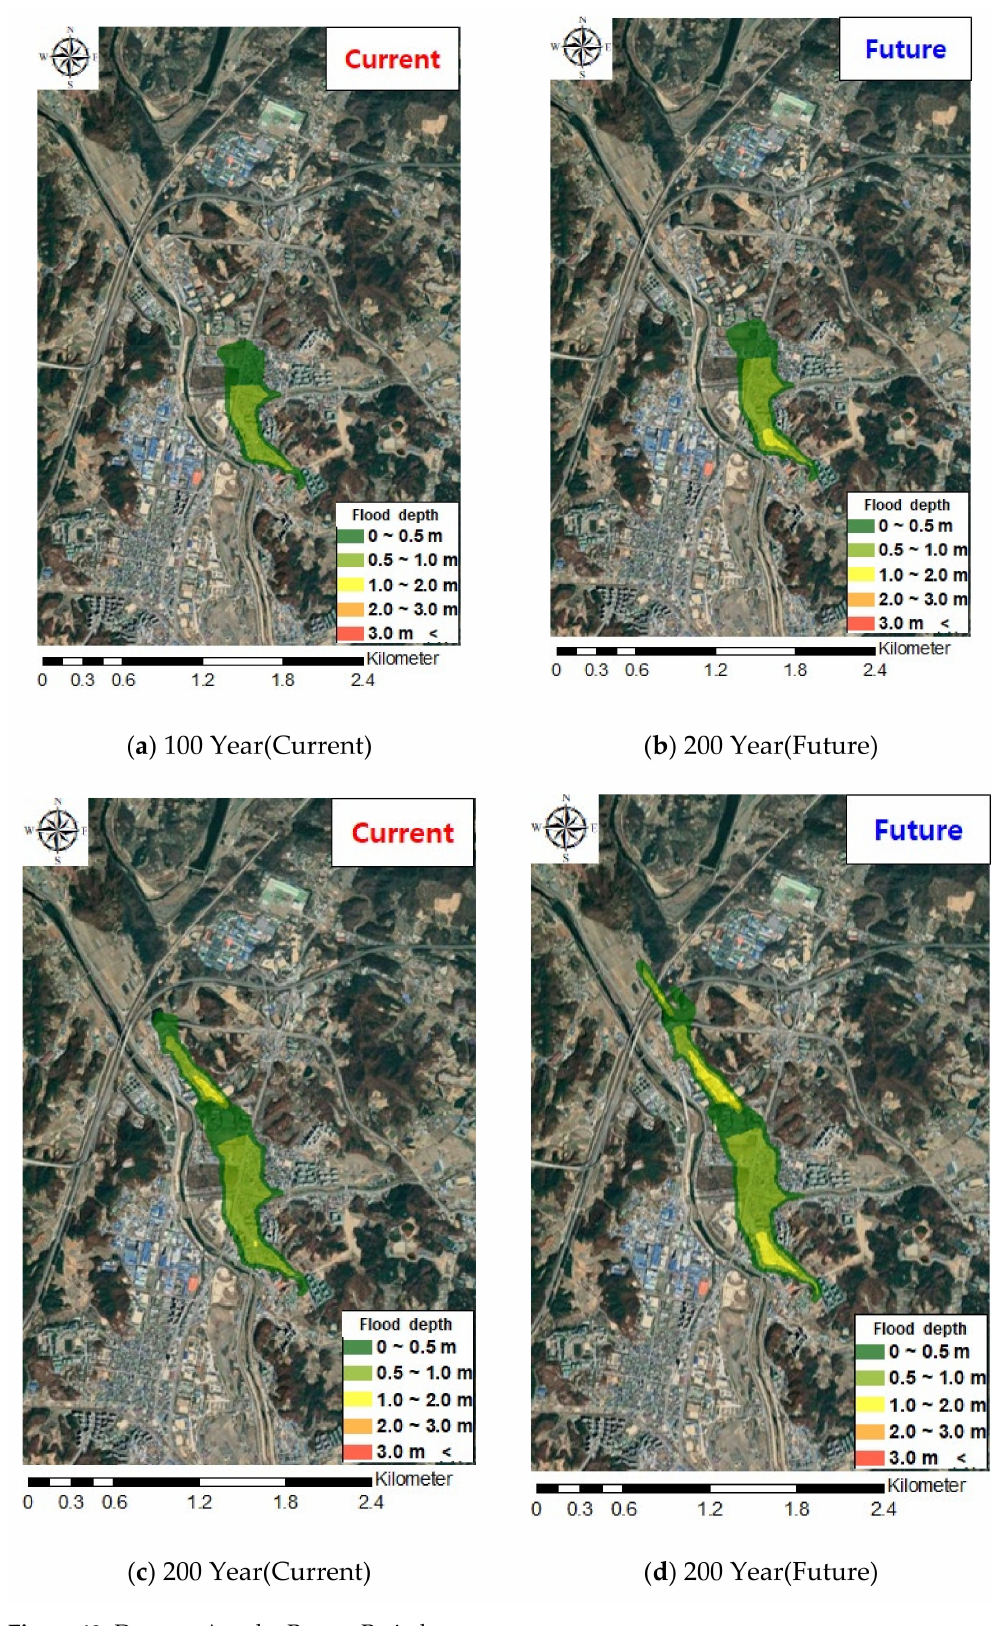
Figure 13. Damage Area by Return